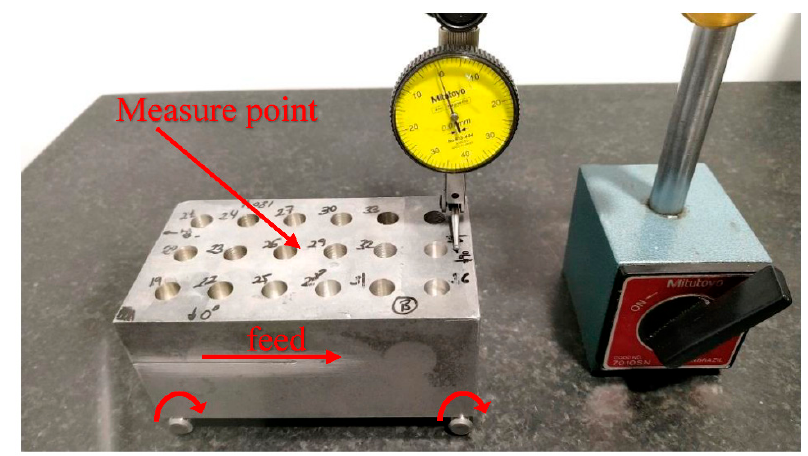
Figure 4. Burr height measurement system.